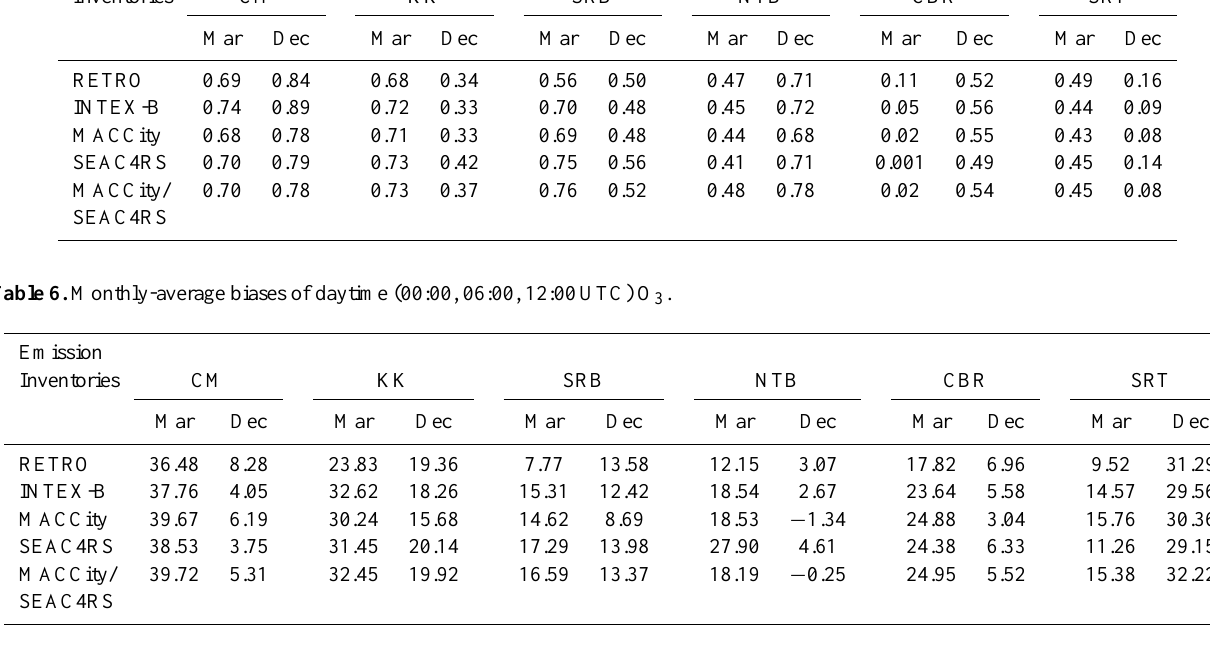
Table 5. Monthly-average correlation coefficients of daytime (00:00, 06:00, 12:00UTC) O 3 . Emission